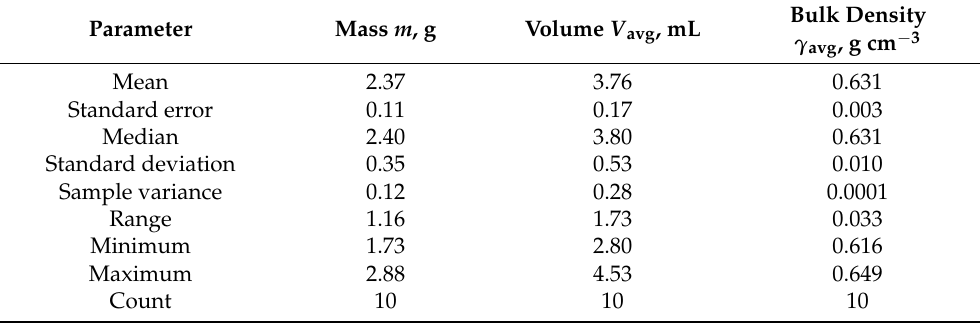
Table 4. The hundred-granule sample mass, volume, and bulk density for the Agro Organic fertilizer.